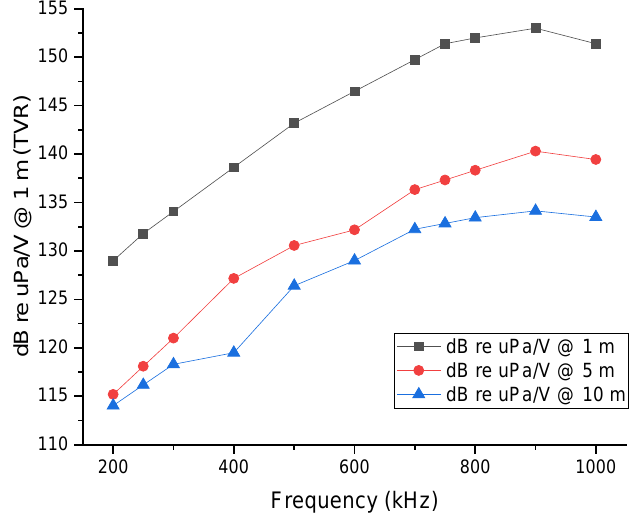
Figure 7. Transmitted voltage response as function of frequency for 1, 5, and 10 m distance between 200 and 1000 kHz.